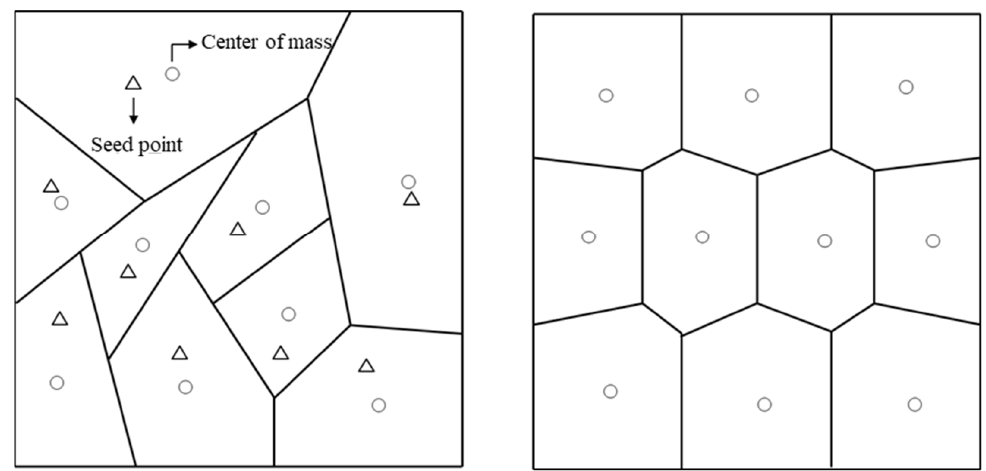
Figure 5. Voronoi Diagram ( Left ) and Centroidal Voronoi Diagram ( Right ).